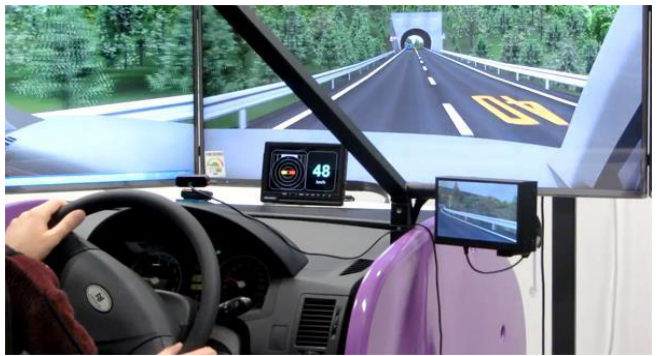
Figure 1. Typical dynamics of accelerator and brake pedals during (a) accelerating, (b) cruising, (c) slowing down (e.g., approaching corner), (d) normal braking (e.g., approaching a stop sign), and (e) emergency braking, respectively.